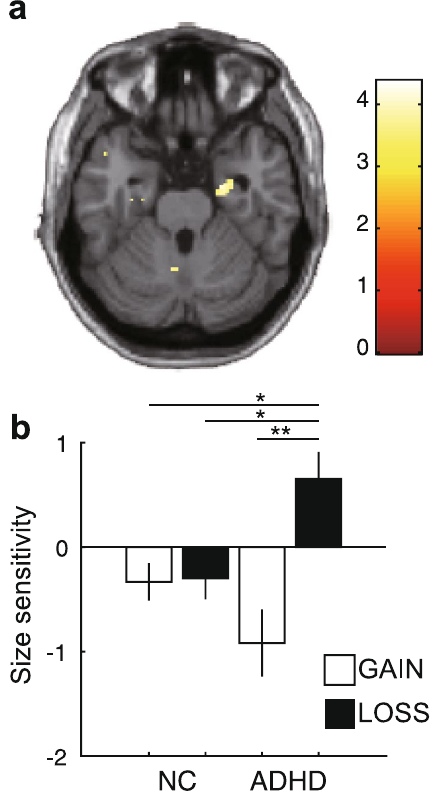
Figure 4. ( a ) Result of the interaction with group and condition (gain/loss) of the BOLD signal for size sensitivity (see Supplementary Table S2; P < 0.05 for visualization). ( b ) BOLD signal for size sensitivity in the GAIN (white bars) and LOSS (grey bars) conditions in the anatomically defined region of interest of the left and right caudate heads (red coloured area) ( * P < 0.01, ** P < 0.001, multiple comparison with the Tukey–Kramer method). Error bars denote ± 1 s.e.m. ( n = 17 for NCs, n = 14 for